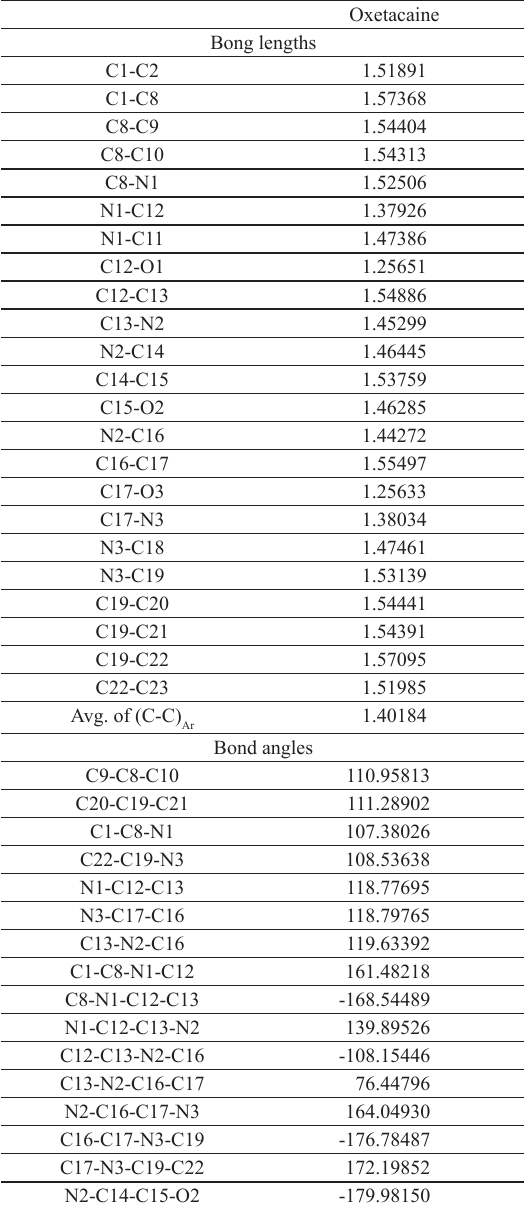
Table 5. Selected Bond Lengths (in angstroms) and Bond Angles (in degrees) of the oxetacaine with B3LYP/6-31G(d,p).